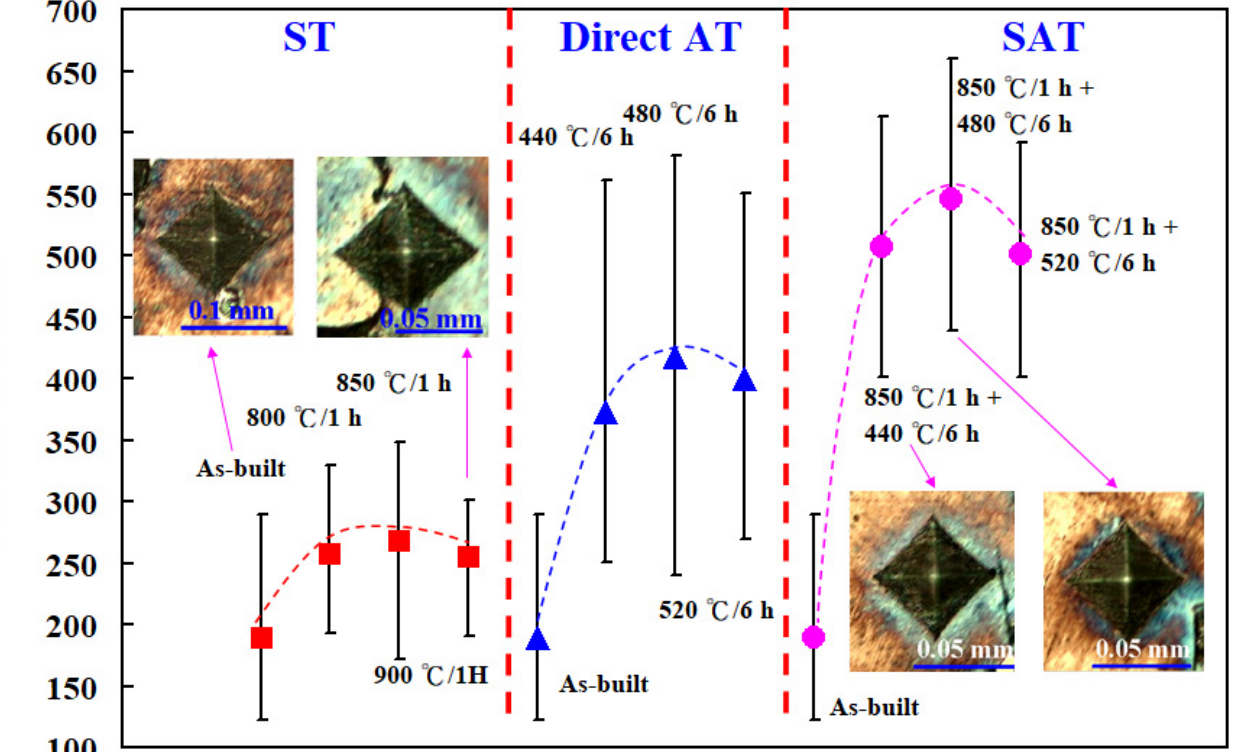
Figure 5. Vickers hardness of the test specimens after heat treatment.